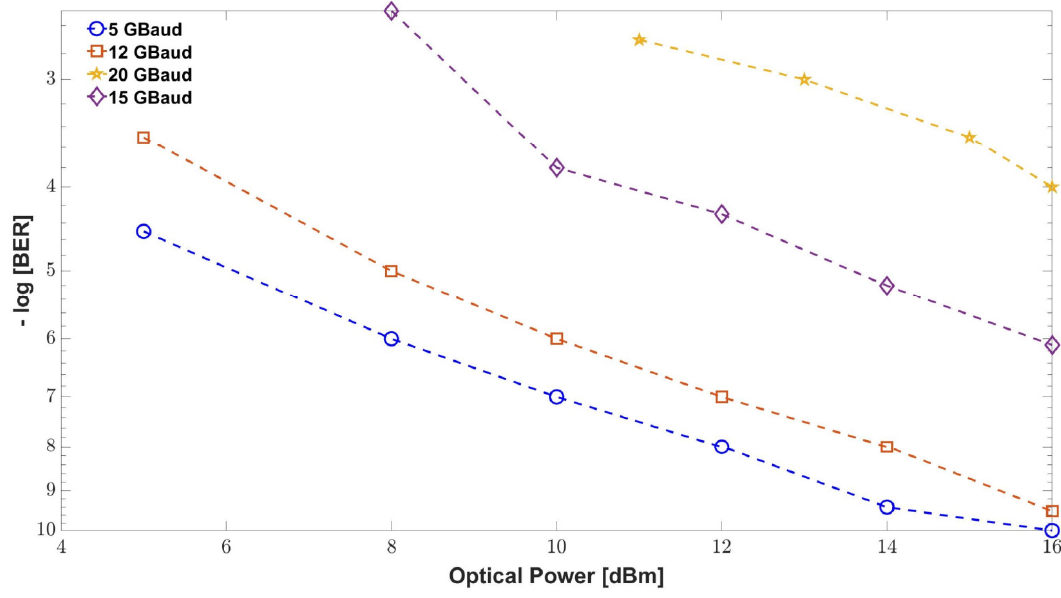
Figure 10. Profile of increasing baud rate for varying optical power in terms of BER.